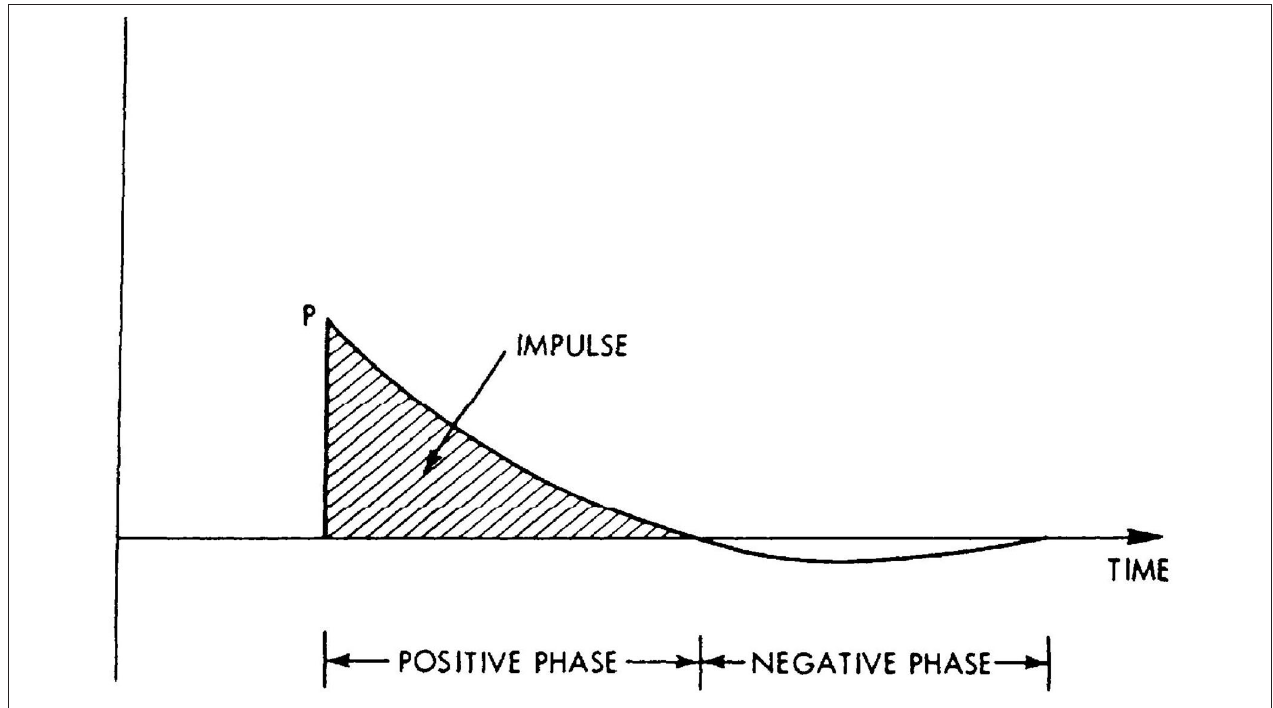
FIGURE 1 | Graphical depiction of a Friedlander Curve